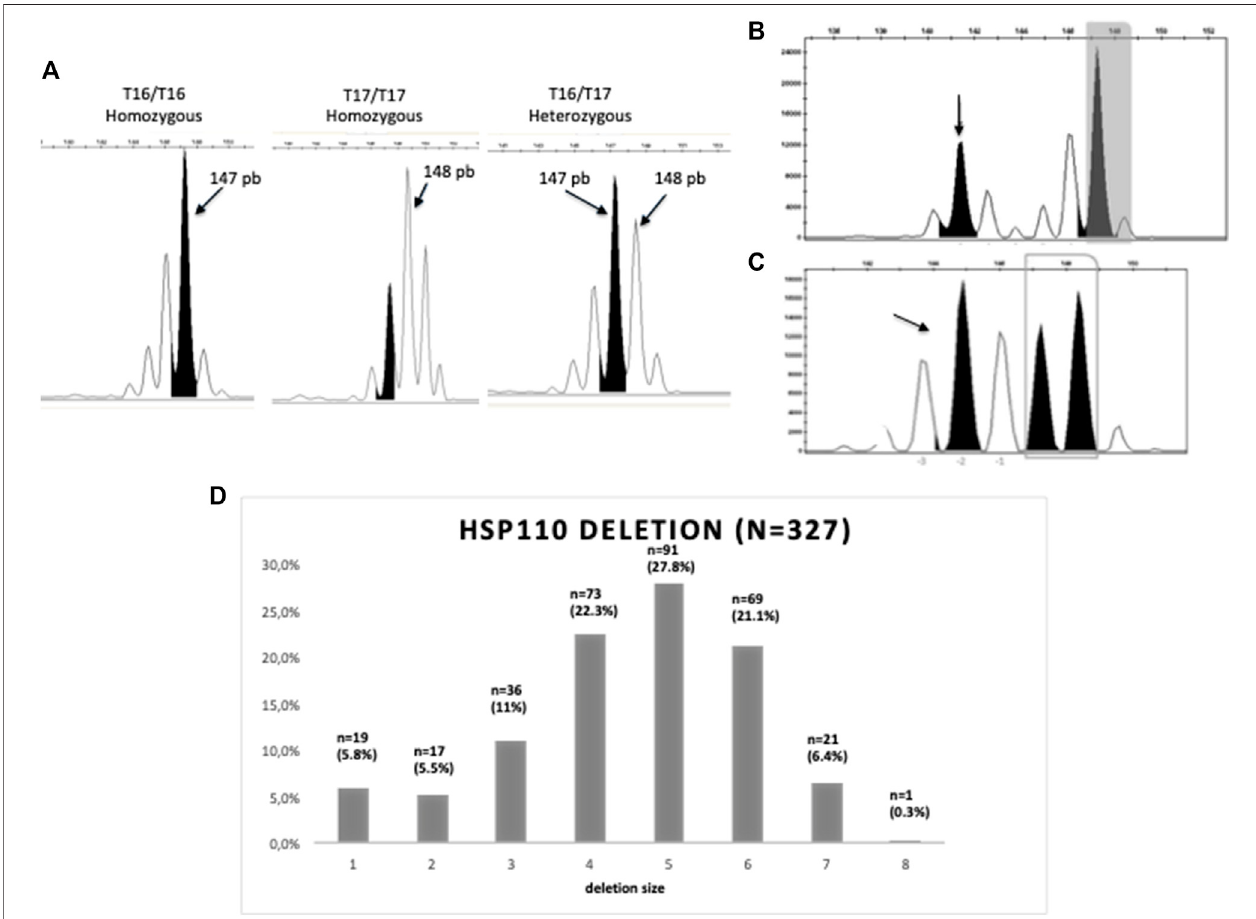
FIGURE1| Moleculardeterminationof HSP110T 17 deletion. (A) Homozygous T 16 /T 16 and HSP110T 17 /T 17 andheterozygous T 16 /T 17 HSP110pro fi lesfromMSS CRC tissues. Peak of 147bp is indicated in black. (B) MSI tumor with a large deletion ( − 5bp) of HSP110 T 17 . (C) MSI tumor with a small deletion ( − 2bp) of HSP110 T 17 . The gray frame is the polymorphic area. Arrows indicate the size of the deleted transcript. (D) Distribution of samples according to the size of HSP110 T 17 deletion.